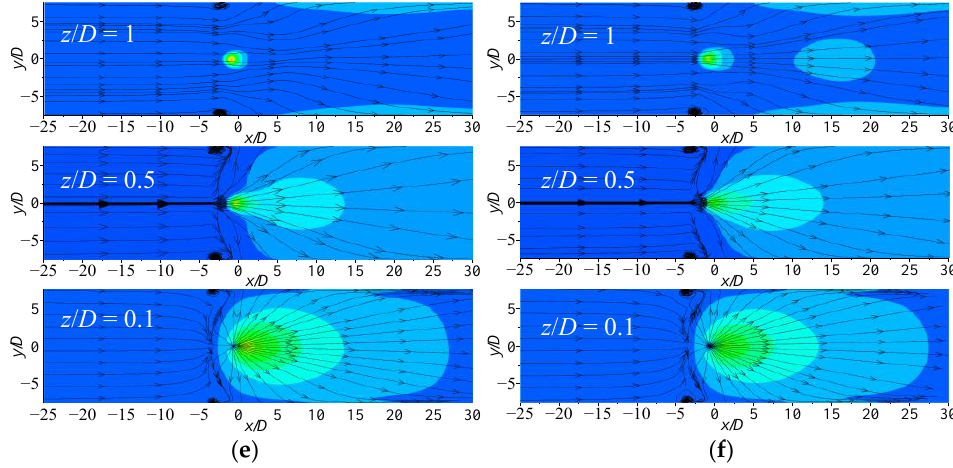
Figure 6. Normalized mean velocity V/V b cloud chart and streamline of different cross sections at various impinging height: ( a ) H/D = 1; ( b ) H/D = 2; ( c ) H/D = 3; ( d ) H/D = 4; ( e ) H/D = 6; ( f ) H/D = 8. Figure 7 shows the axial velocity V/V b , horizontal velocity |V x |/V b , and vertical velocity |V z |/V b ( H/D = 1, 8) of the jet at different Reynolds numbers ( Re = 11,700~35,100). When H/D = 1, V/V b remains unchanged in the range of 0 ≤ l/D ≤ 0.2; when l/D ≥ 0.2, V/V b decreases with the increase in l/D , |V z |/V b decreases rapidly from 0.9 to 0, and |V x |/V b remains unchanged after slightly decreasing. At the same axial location, l/D , the values of V/V b , |V x |/V b , and |V z |/V b at low Reynolds numbers are slightly higher than those of higher Reynolds numbers, but the velocity profiles have good similarity. When H/D = 8, V/V b , |V x |/V b and |V z |/V b decrease gradually with the increase in l/D in the potential core region and transition region ( 0 ≤ l/D ≤ 10.5), and the decay rates of |V x |/V b and |V z |/V b are fundamentally the same; in the impingement region ( l/D ≥ 10.5), the decay rates of |V x |/V b and |V z |/V b increase. It can be seen from Figure 7 that an increase in impinging height leads to an increase in jet flow distance and a decrease in jet velocity when it reaches the impingement region. The velocity profiles are similar under different levels of Re , which indicates that Reynolds number has little effect on velocity profiles.